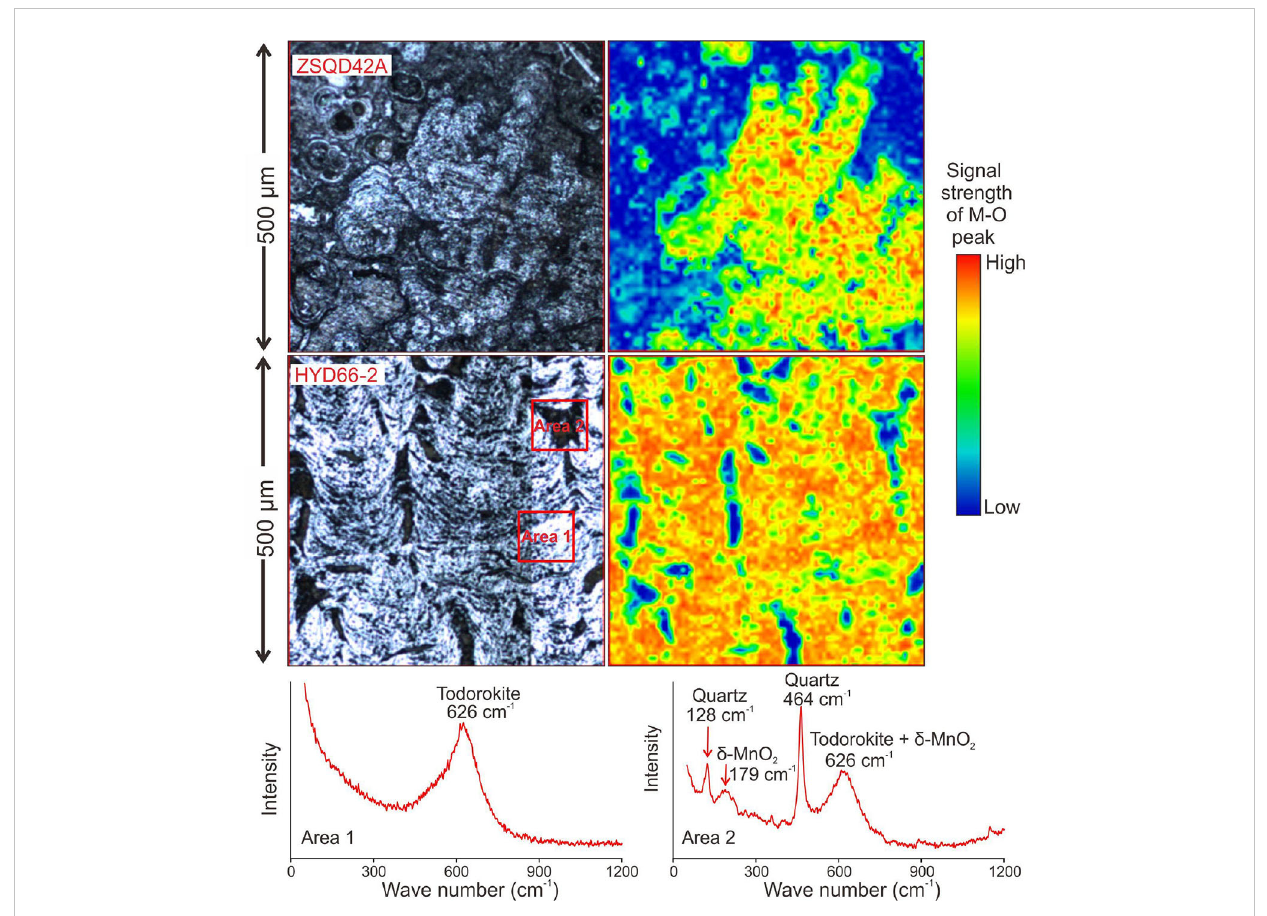
FIGURE 4 Raman mapping results of the selected area in the samples ZSQD42A and